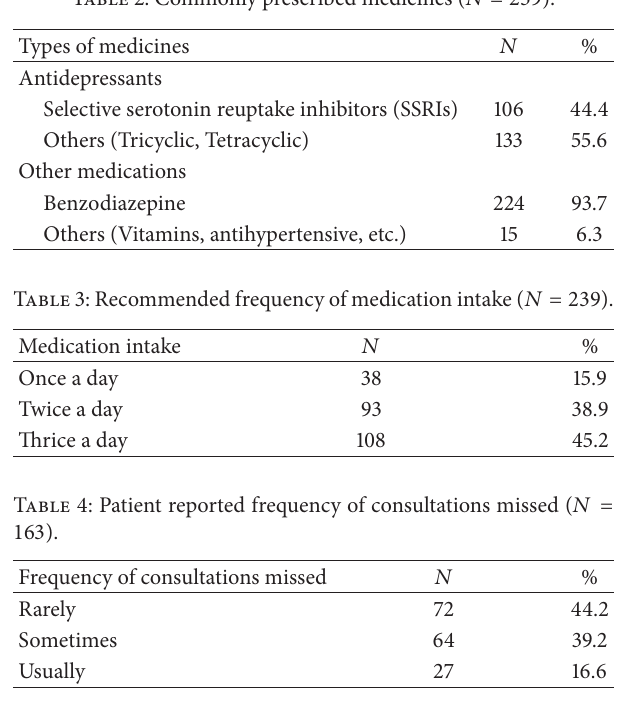
Table 2: Commonly prescribed medicines ( 𝑁 = 239 ).